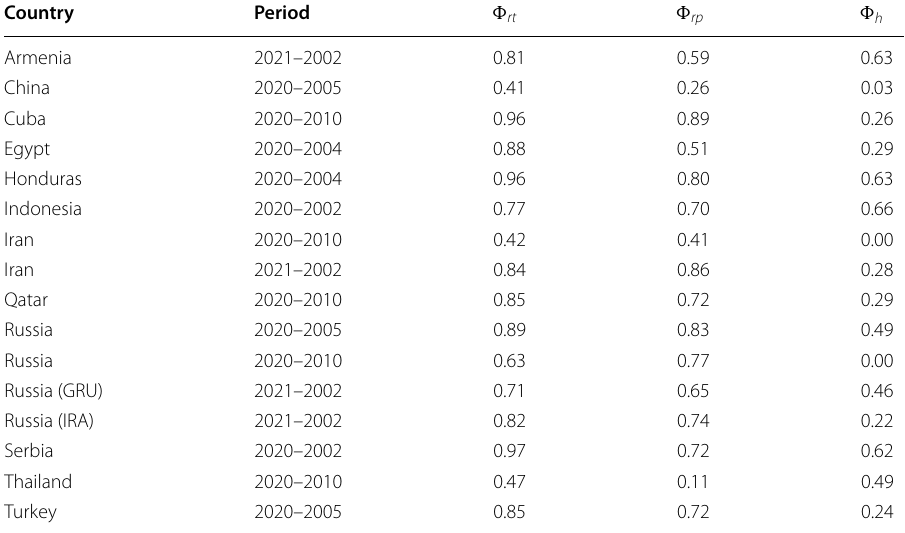
(cid:31) rt denotes the MCC coefficient based on the user-message retweet network. (cid:31) rp denotes the MCC coefficient based on user-message reply network. (cid:31) h denotes the MCC coefficient based on the user-hashtag network